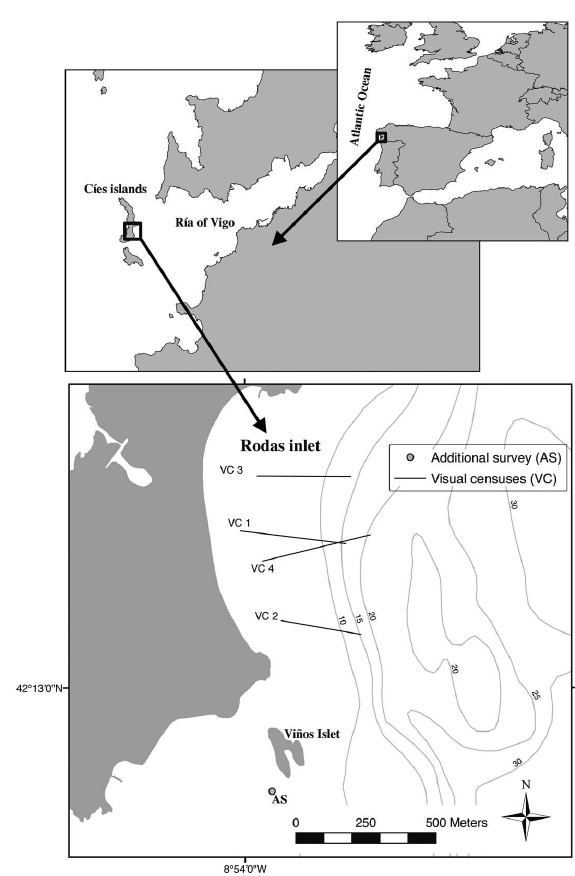
Fig. 1. – Map of the Rodas Inlet within the Cíes Islands (National Park of the Atlantic Islands of Galicia), showing location of visual censuses (VCs).